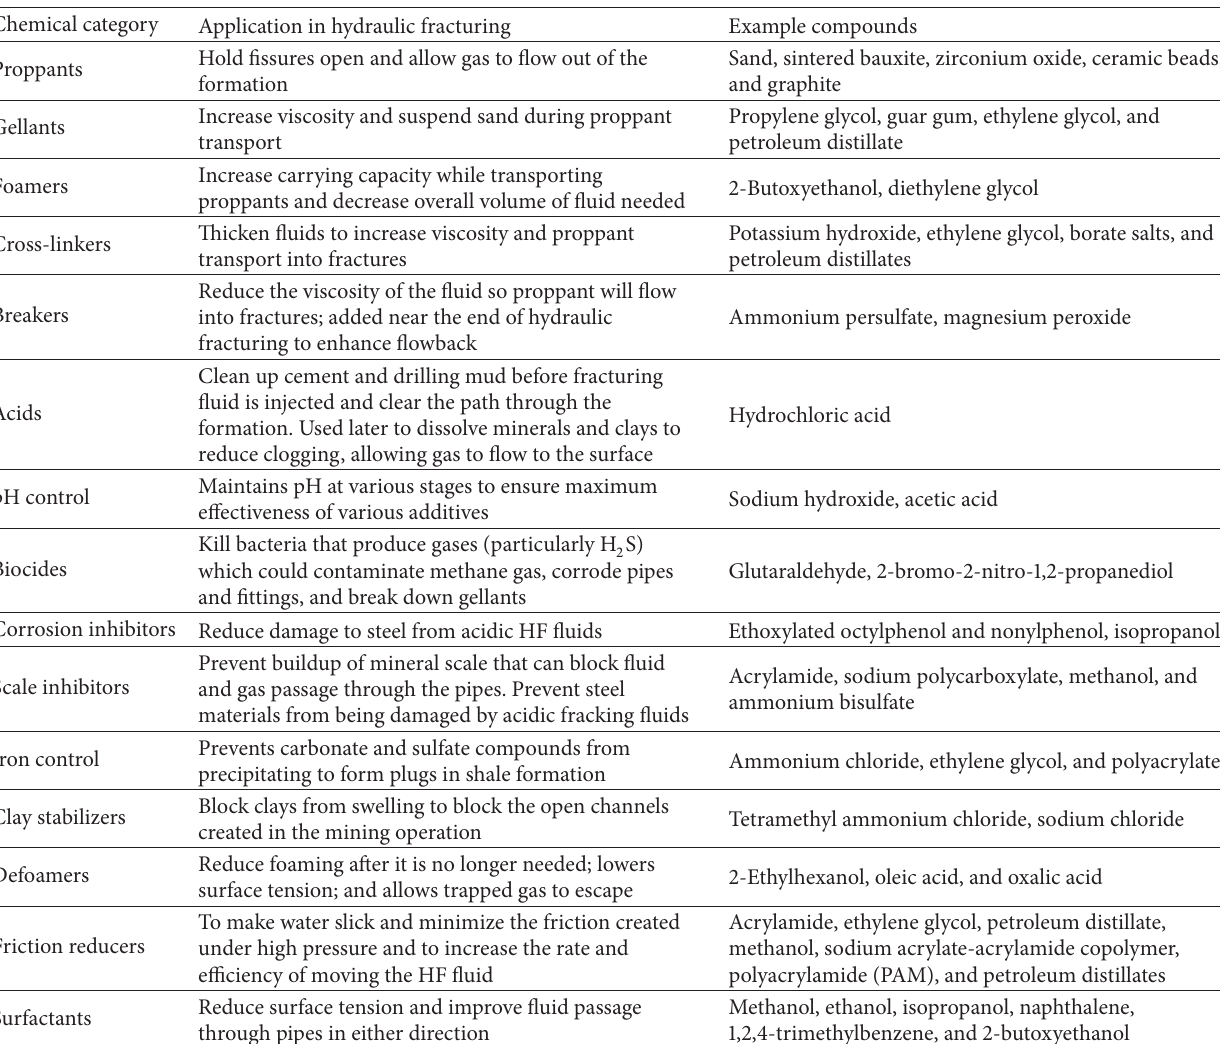
Table 1: Common classes of hydraulic fracturing compounds and their